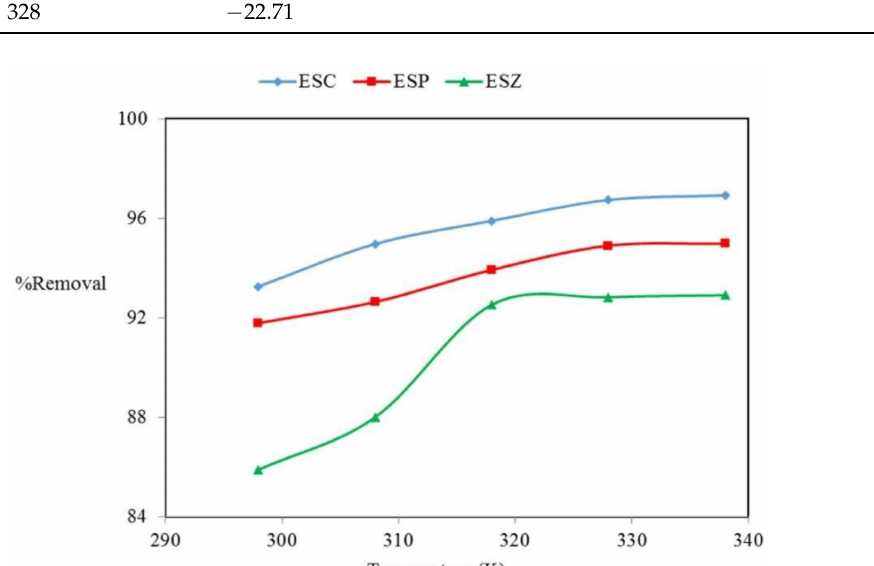
Figure 11. ESC: Ephedra strobilacea char. ESP: E. strobilacea char modified using phosphoric acid. ESZ: E. strobilacea char zinc chloride. Ephedra strobilacea sawdust modified using phosphoric acid and zinc chloride